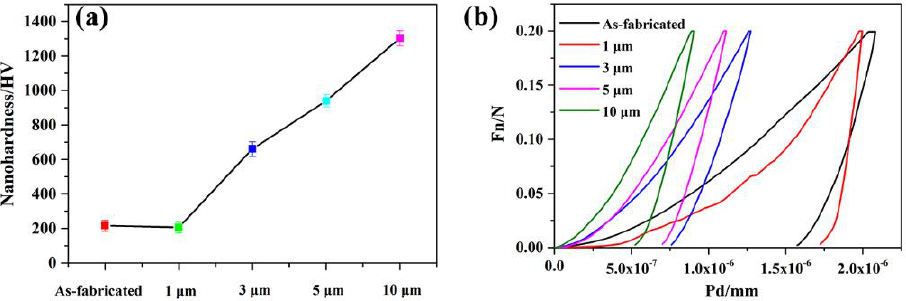
Figure 7. ( a ) Comparison of nano-hardness under different process parameters ( b ) Load-displacement curve of samples surface under different process parameters.